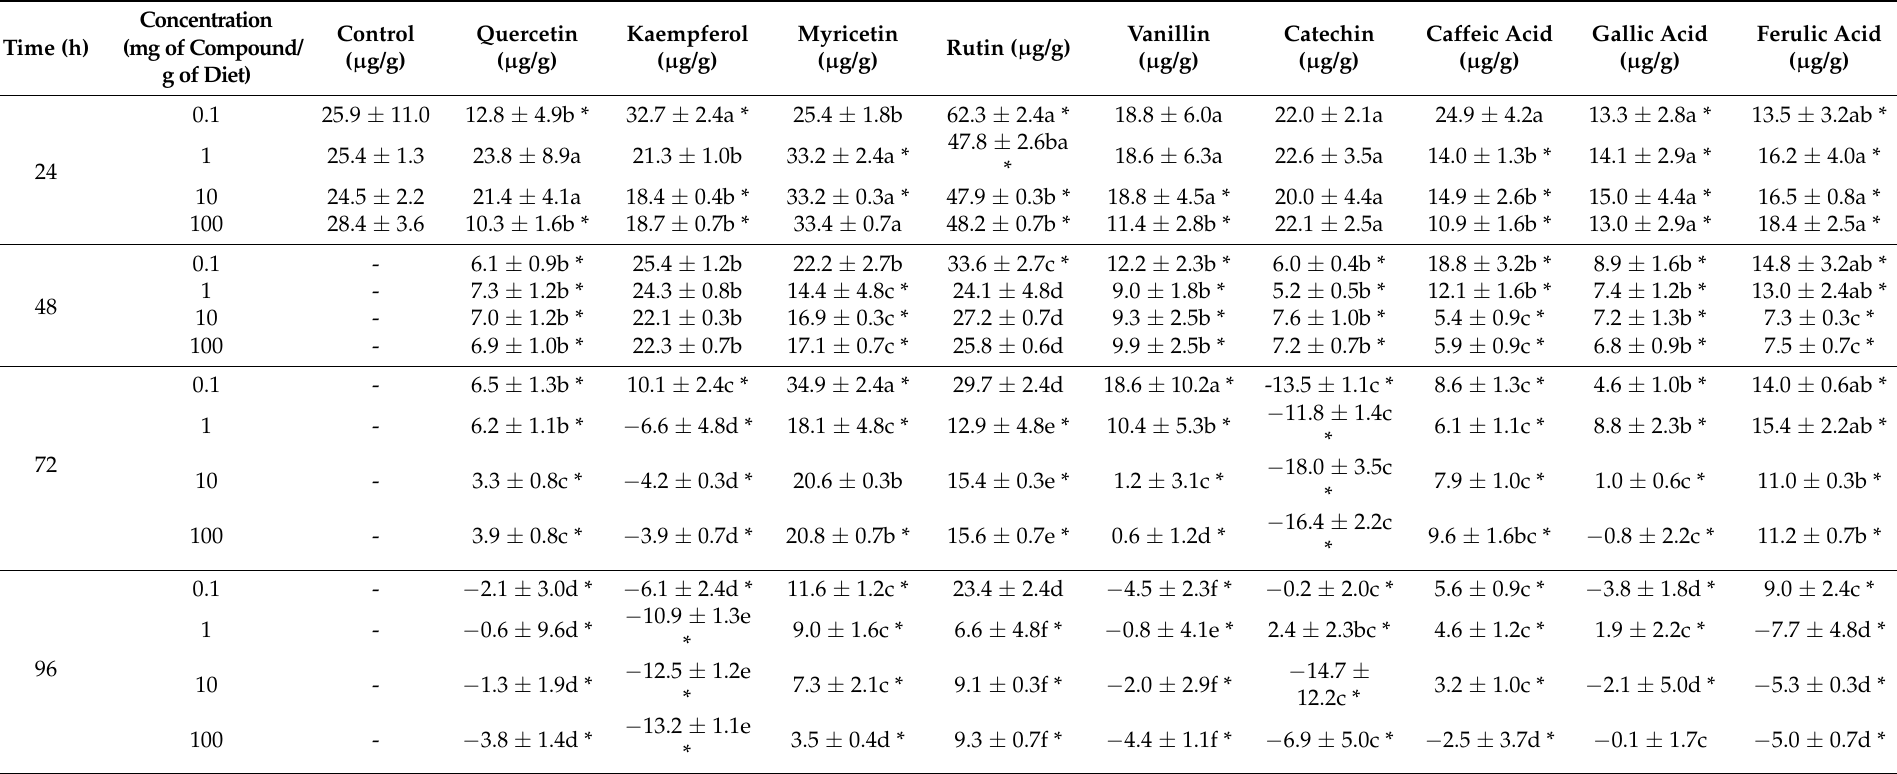
Table 4. Percentage of mass gain at several doses and times (h) for C. rudis . Letters indicate significant differences according to ANOVA followed by Tukey’s test. ANOVA was performed for each compound in relation to dose and time. * Significant differences in relation to control treatment according to Student’s t -test for respective time (h) and concentration.